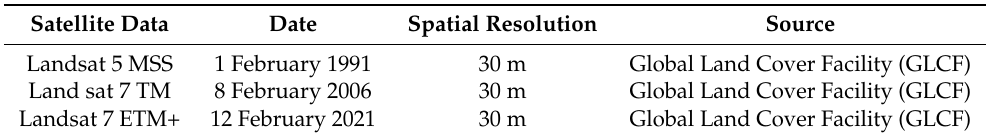
Table 1. Types of satellite